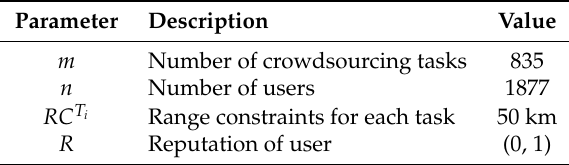
Table 3. The real-world data parameters and their values.